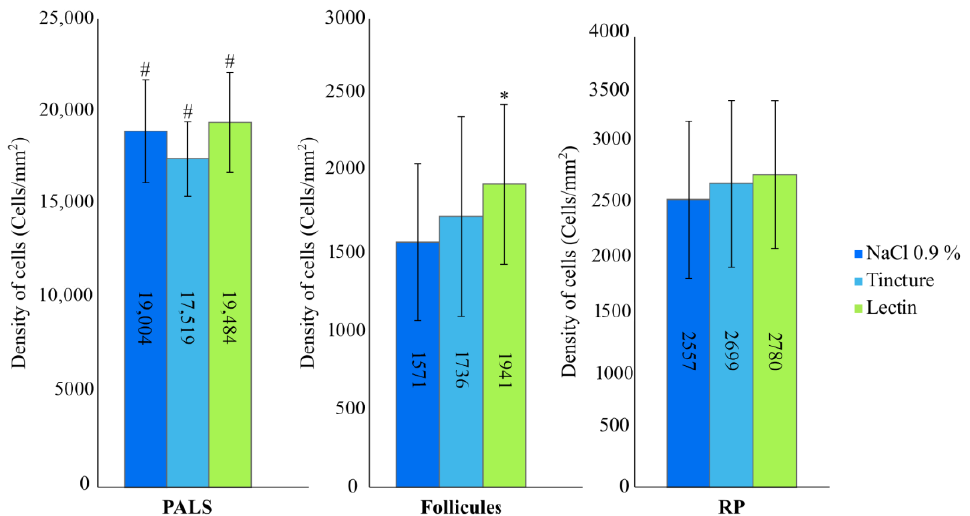
Figure 5. T lymphocytes’ density (cells/mm²) distribution in BALB/c mice spleen. PALS, follicles and red pulp (RP). * p < 0.01 compared with physiological solution’s and p < 0.05 compared with tincture’s group. # Statistical significance p <